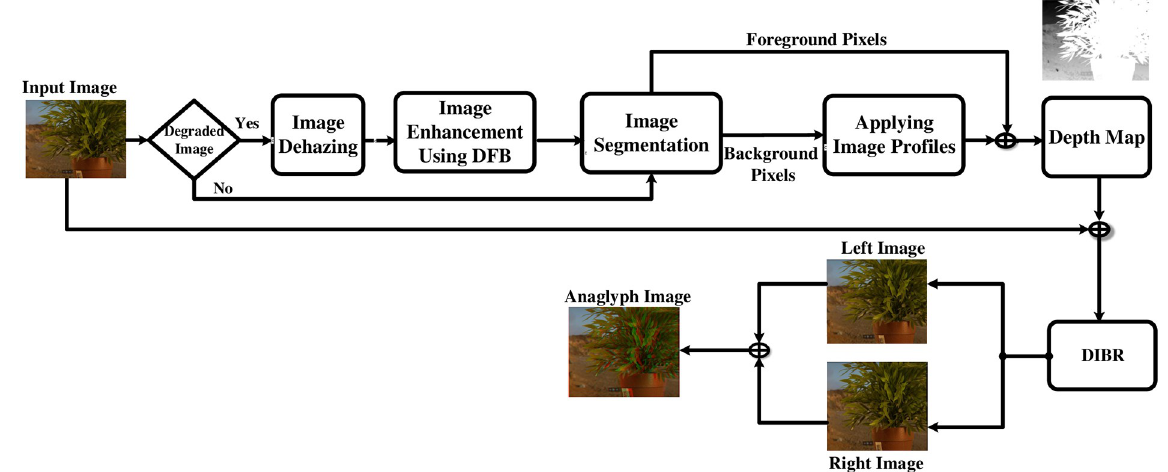
Fig 1. Flow for the proposed Directional Filter Bank Depth Image based Rendering System